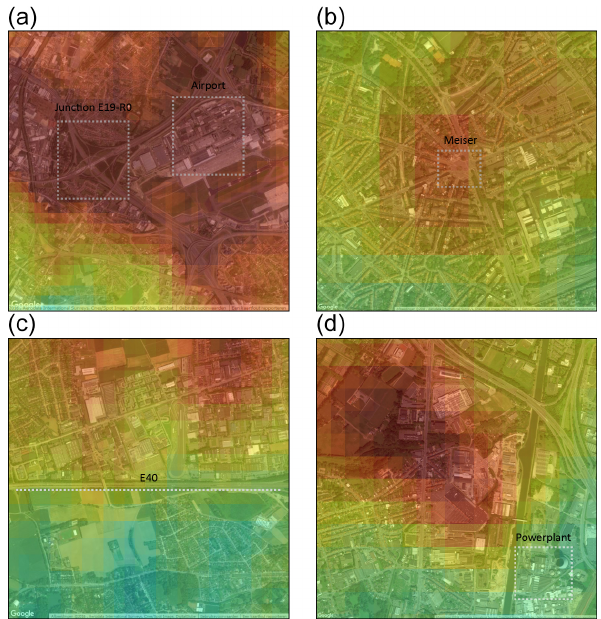
Figure 18. Enlargement of four peculiar NO 2 VCD hotspots in the Brussels data set (30 June 2015): (a) major junction between the ring road R0 and the E19, and Brussels international airport; (b) junction “place Meiser”, close to the city centre; (c) eastern part of the E40 highway; (d) gas turbine Drogenbos power plant. The locations of the four zooms are indicated in Fig. 17 by blue squares (Google,